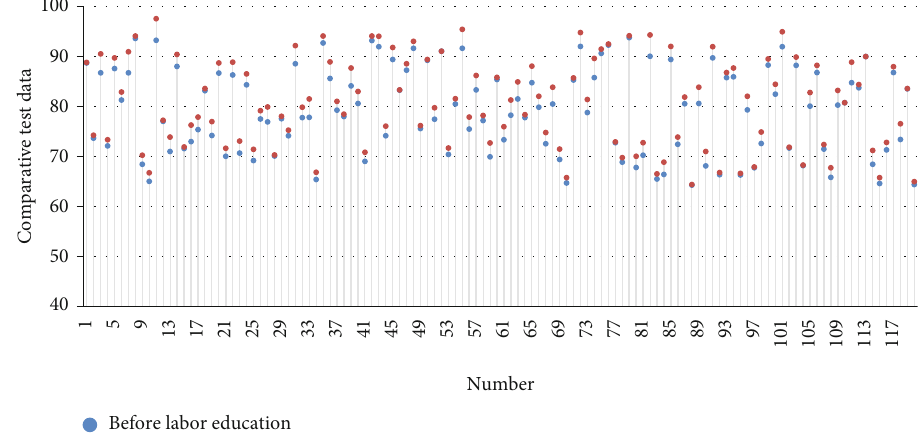
Figure 8: Comparison of compressive capacity.